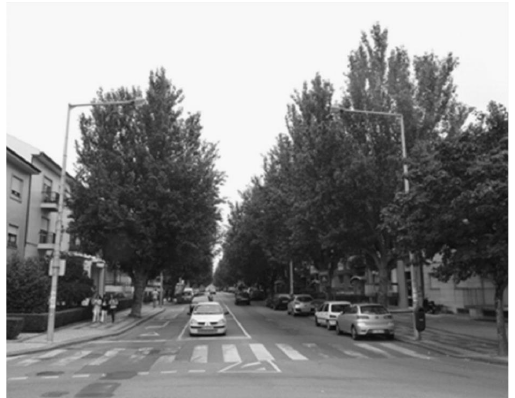
Figure 1. Photographs of Liberdade Avenue in Lisbon [1].